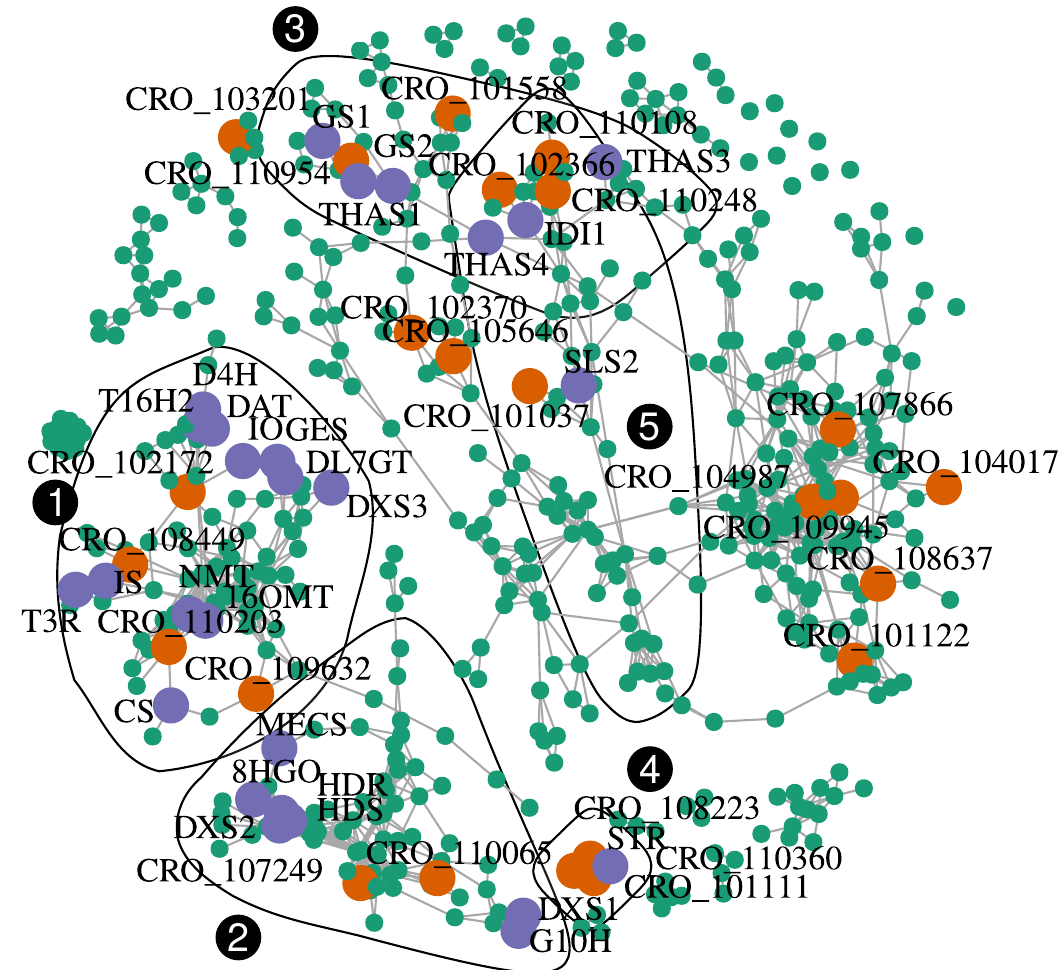
Figure 6. Co-expression network (Spearman’s rho correlation-based) visualizing transcriptional relationships among MIA genes and other differentially methylated and expressed genes detected in this study . MIA genes are indicated by purple points and black labels, while differentially expressed and methylated genes are indicated in turquoise or orange if they code potential transcription factors (Table 1). Genes are connected by grey segments if their Spearman’s rho coefficient was above 0.95. Black polygons correspond to communities detected with a fast greedy modularity optimization based algorithm. Only communities containing at least one MIA gene are shown. Numbers in white in black circles correspond to community identification